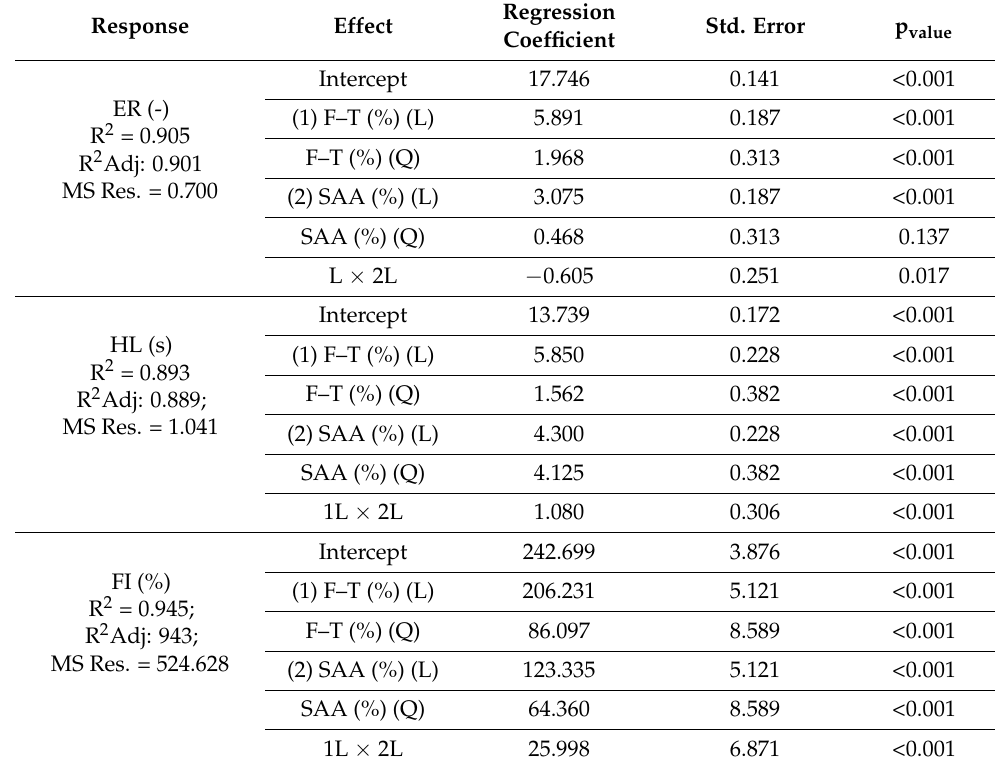
Table 10. Parameters of the model expressing the relationships between ER, HL, FI and the F–T wax and SAA content in bitumen 50/70. Response Effect